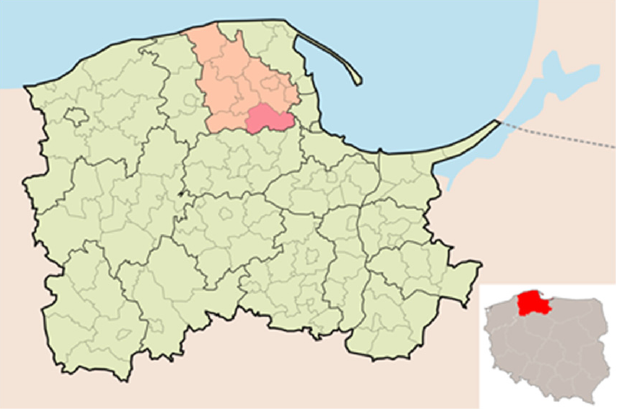
Figure 3. Location of Szemud Municipality [62].